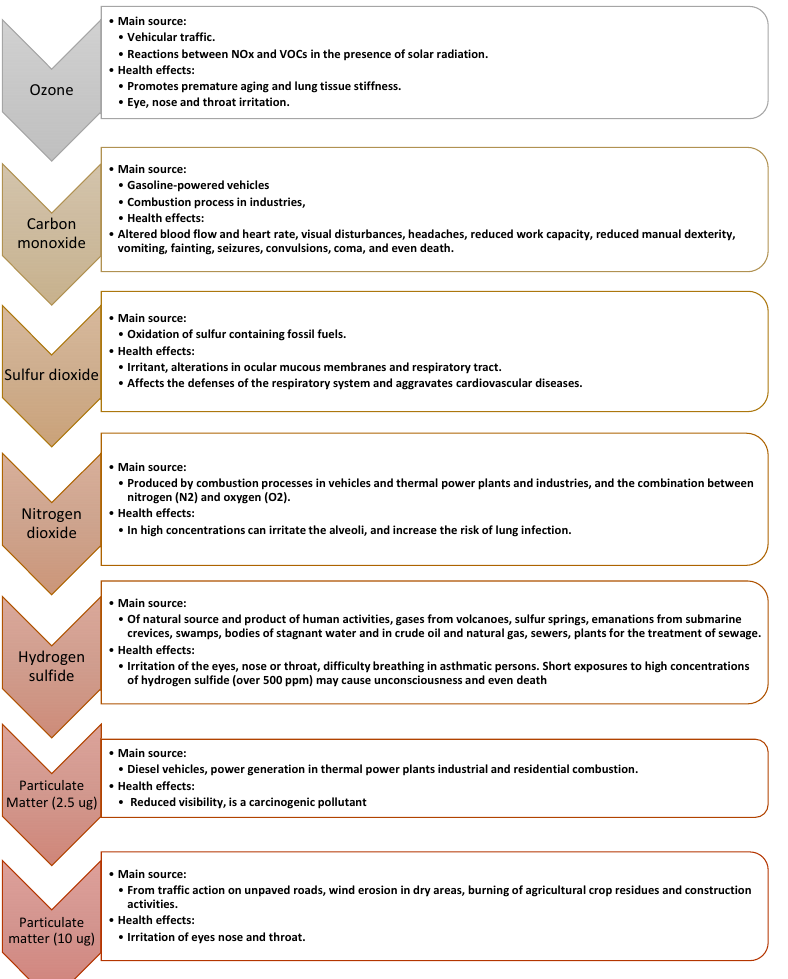
Figure 4. Main pollutants and consequences of urban air, adapted from Outdoor Air Pollution, Cuenca–Ecuador 2020 [7].